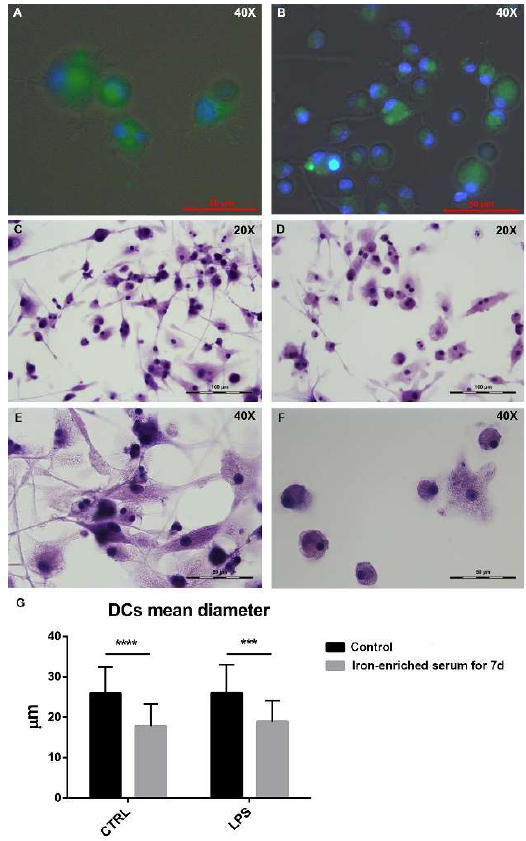
Figure 3. Fluorescence staining of BMDCs administered with FITC-dextran (Fluorescein isothiocyanate-dextran), control cells stimulated with LPS for 24 h ( A ) and cells grown in iron-enriched medium for seven days stimulated with LPS for 24 h ( B ). Hematoxylin staining for control cells stimulated with LPS for 24 h ( C , E ) and cells grown in iron-enriched medium for seven days and stimulated with LPS for 24 h ( D , F ) shows their di ff erent size and morphology. Bar plot shows a significant di ff erence in DCs size ( G ). Images were taken with a 20 × objective and a 40 × immersion objective. *** p < 0.001 **** p < 0.0001.